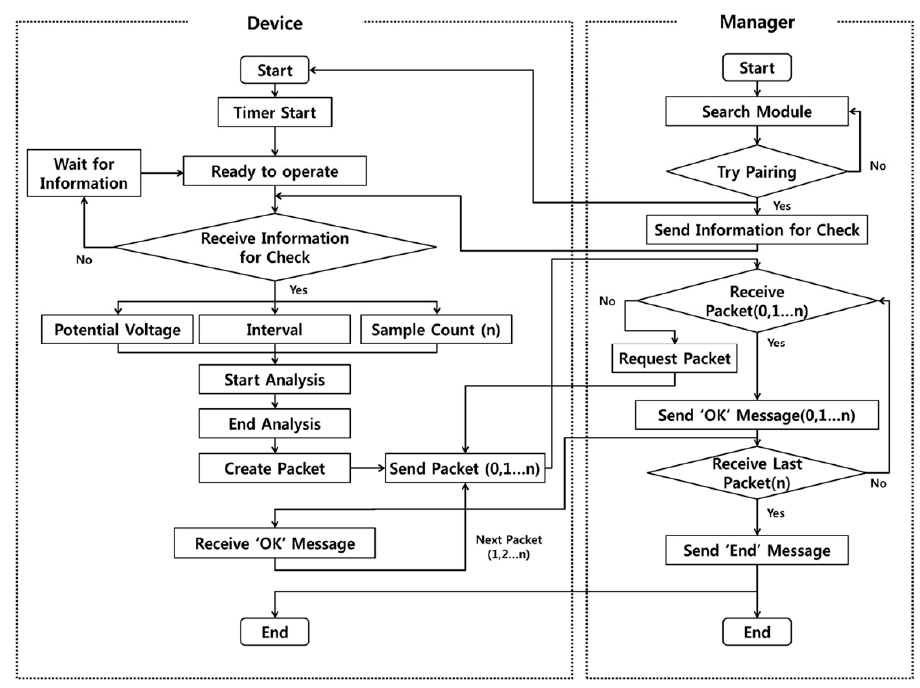
Figure 3. System operation flow via Bluetooth communication.